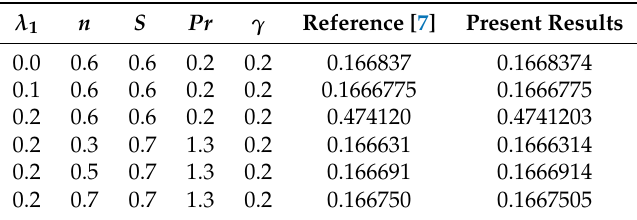
Table 2. Variations in Nu x R = Sr = M = Sc = Du = 0.